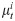
A schematic of the mechanism of DNA replication encoded in Repli-Sim.Repli-Sim includes local origin parameters (position xi, competence ci, and mean firing time μti) and global parameters (firing time variance σt, mean forks’ speed μv and its variance σv). When an origin of replication activates, two forks are formed and elongate bidirectionally until they meet an approaching fork. The speed of an individual fork is constant, but vary between forks, even if they emanate from the same origin. The continuous length of the replicated DNA (Δx, DNA tracks) are shown with the dashed lines.